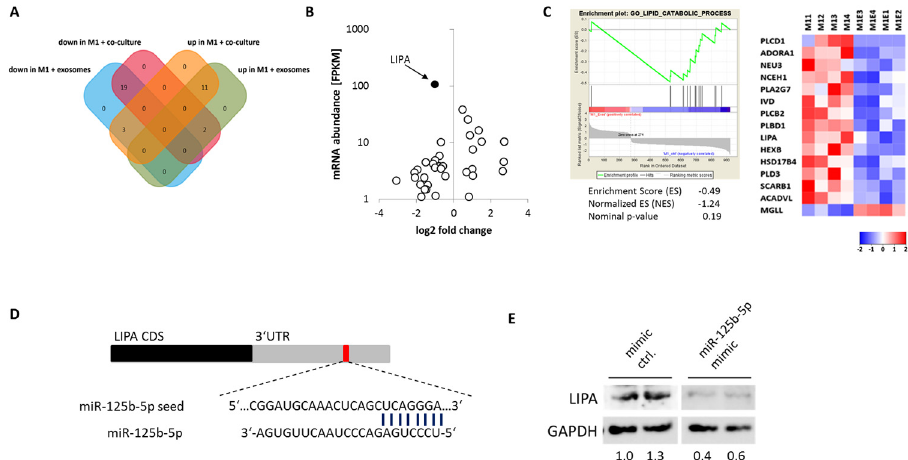
Figure 6. miR-125b-5p targets LIPA. ( A ) Venn diagram shows expression (NGS) direction overlap of potential miR-125b-5p target mRNAs in M1 macrophages after 48 h co-culture with MV3 cells or MV3-derived exosome treatment. ( B ) Volcano plot examines the mRNA abundance [FPKM] and log2 fold change (M1 + Exos versus M1; p ≤ 0.05) of predicted miR-125b-5p targets. ( C ) Gene set enrichment analysis shows a decreased expression of genes associated with lipid metabolism after M1 macrophages were treated (48 h) with melanoma exosomes. Heatmap shows differential expression of gene set: GO lipid catabolic process. ( D ) Scheme of predicted miR-125b-5p binding site in lysosomal acid lipase A (LIPA) 3’UTR. ( E ) Western blot for LIPA protein expression in M1 macrophages 48 h after transfection with miR-125b-5p mimic or control mimic, respectively.